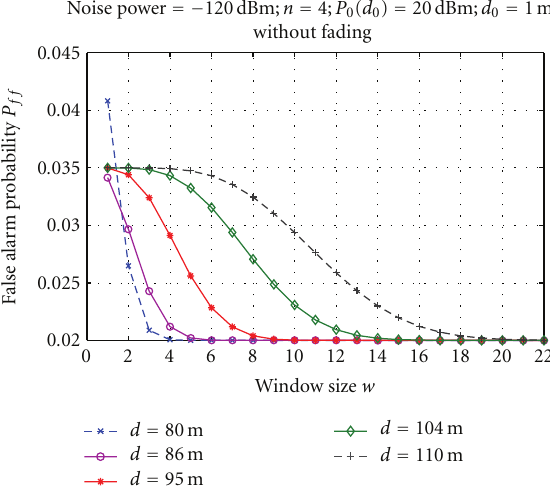
Figure 4: False alarm probability P f f versus Window size